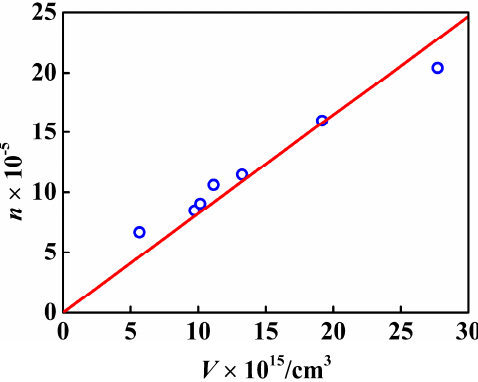
Figure 8. Variation of n (the number of the carboxyl moiety per PSA nanosphere) with V (the PSA nanosphere volume).